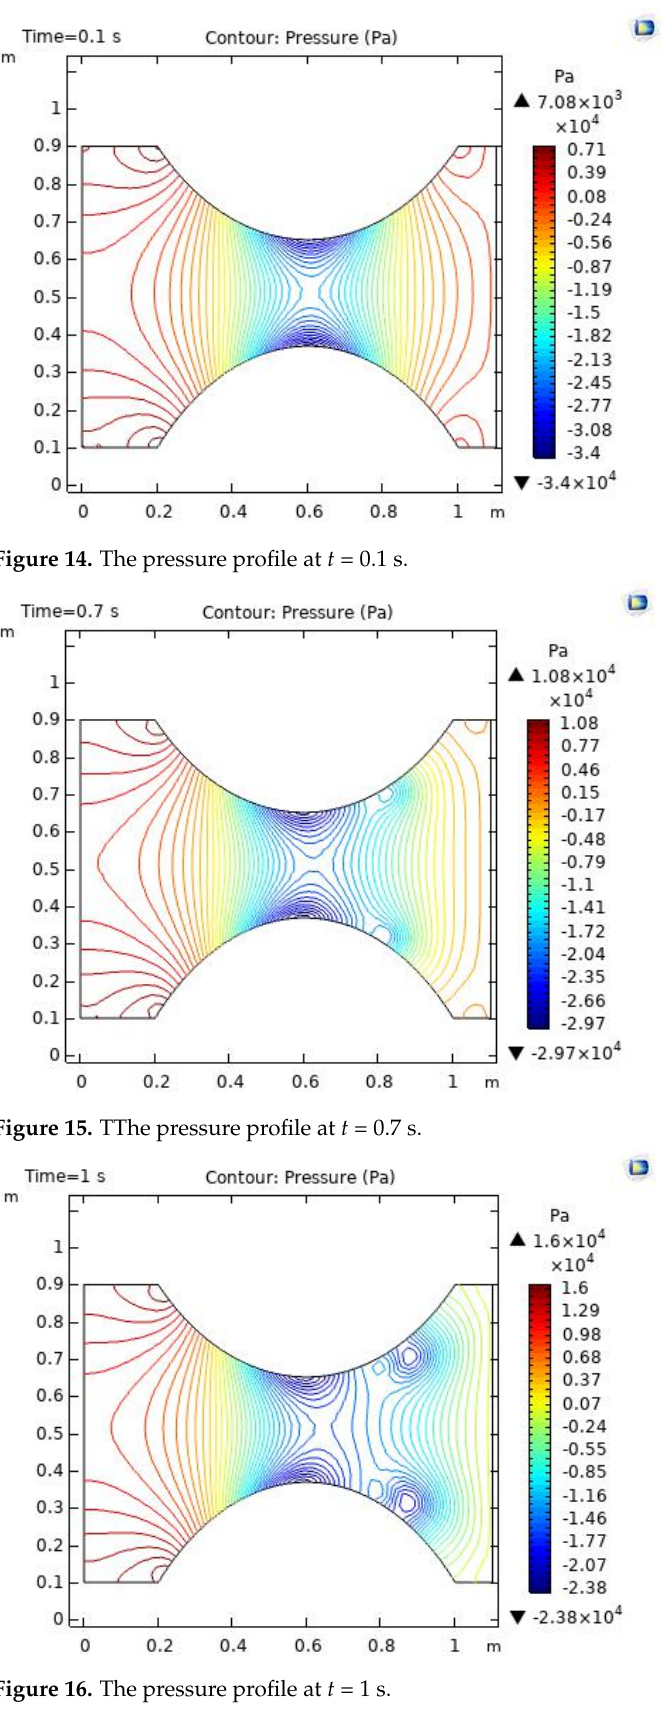
Figure 13. The temperature profile at t = 1 s.